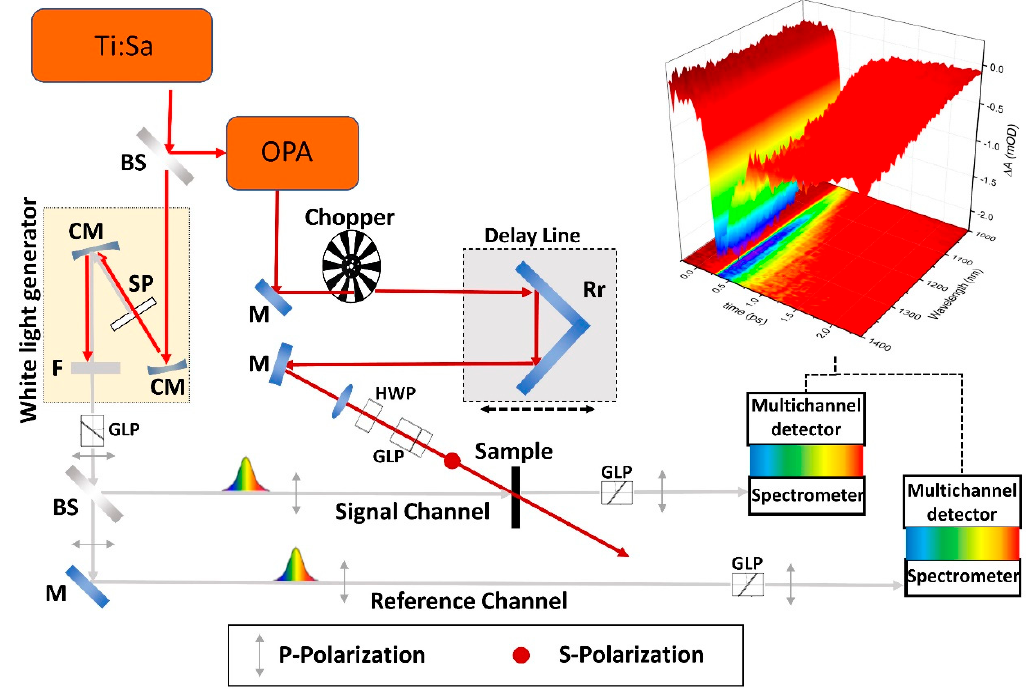
Figure 1. Schematic representation of the setup for ultrafast hyperspectral transient absorption spectroscopy with crossed polarization of pump and probe. The system was based on an amplified 800 nm mode-locked Ti:Sapphire laser. A pair of multichannel optical detectors allow for the acquisition of the entire spectrum. The samples were optically pumped using the spectrally tunable femtosecond pulses generated in the OPA. The induced changes in transmission were probed using the white-light supercontinuum. Other components: DL, delay line; M, mirror; BS, beam splitter; SP, sapphire plate; F, long-pass filter; Rr, retroreflector; GLP, Glan-laser polarizer; HWP, half-wave plate. The technique reconstructs the time and wavelength dependent change in the sample absorbance ∆ A ( λ , t ) (2D spectrograms) induced by the pump.